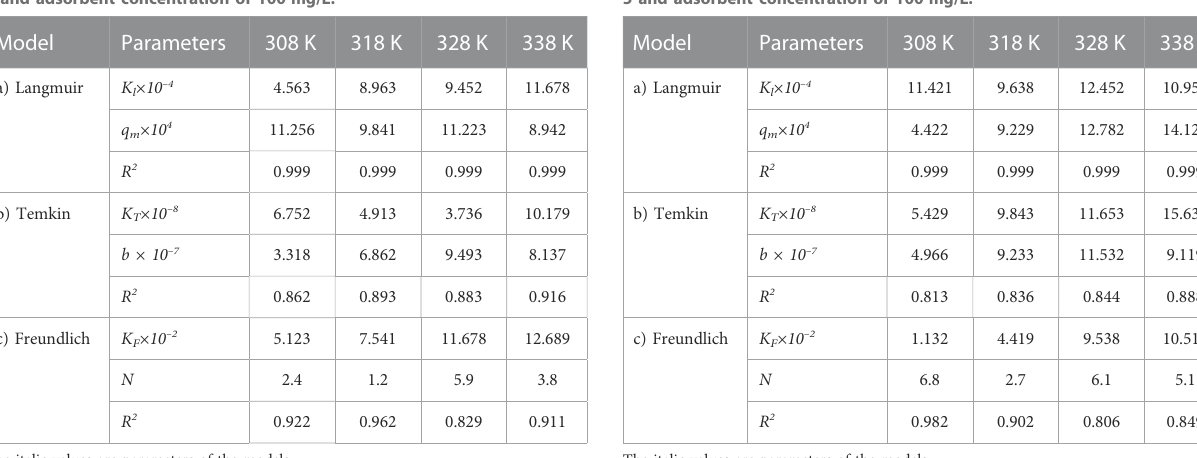
TABLE 7 Parameters of a) Langmuir, b) Temkin, and c) Freundlich isotherm models at different temperatures using Oil sludge 4 as carbon active at pH = 5 and adsorbent concentration of 100 mg/L.